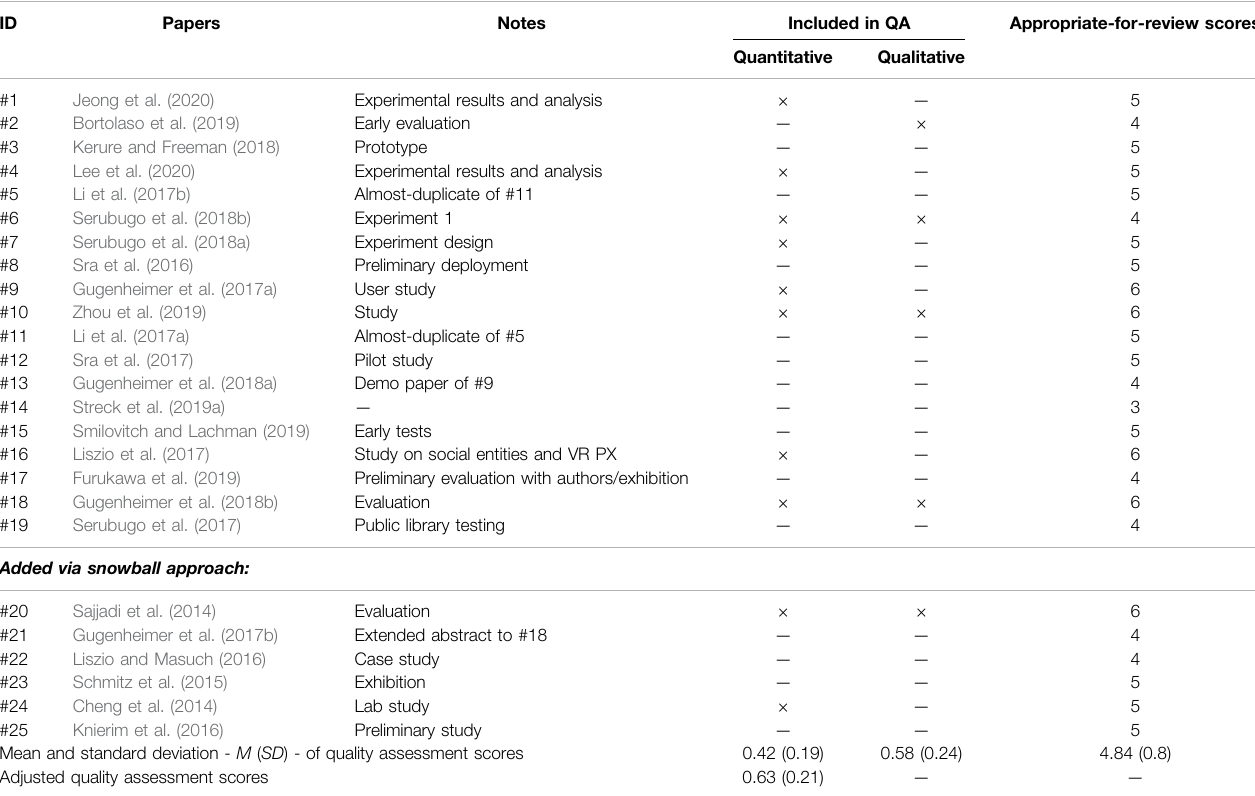
TABLE 2 | Quality assessment scores of the identi fi ed papers in our literature review. The range of overall quantitative and qualitative scores were 0 – 1; 1 represents the highest possible point (Kmet et al., 2004). For appropriateness scores (Connolly et al., 2012), 6 constitutes the highest possible score while 2 equates to the lowest score. In the synthesis, we refer to papers by